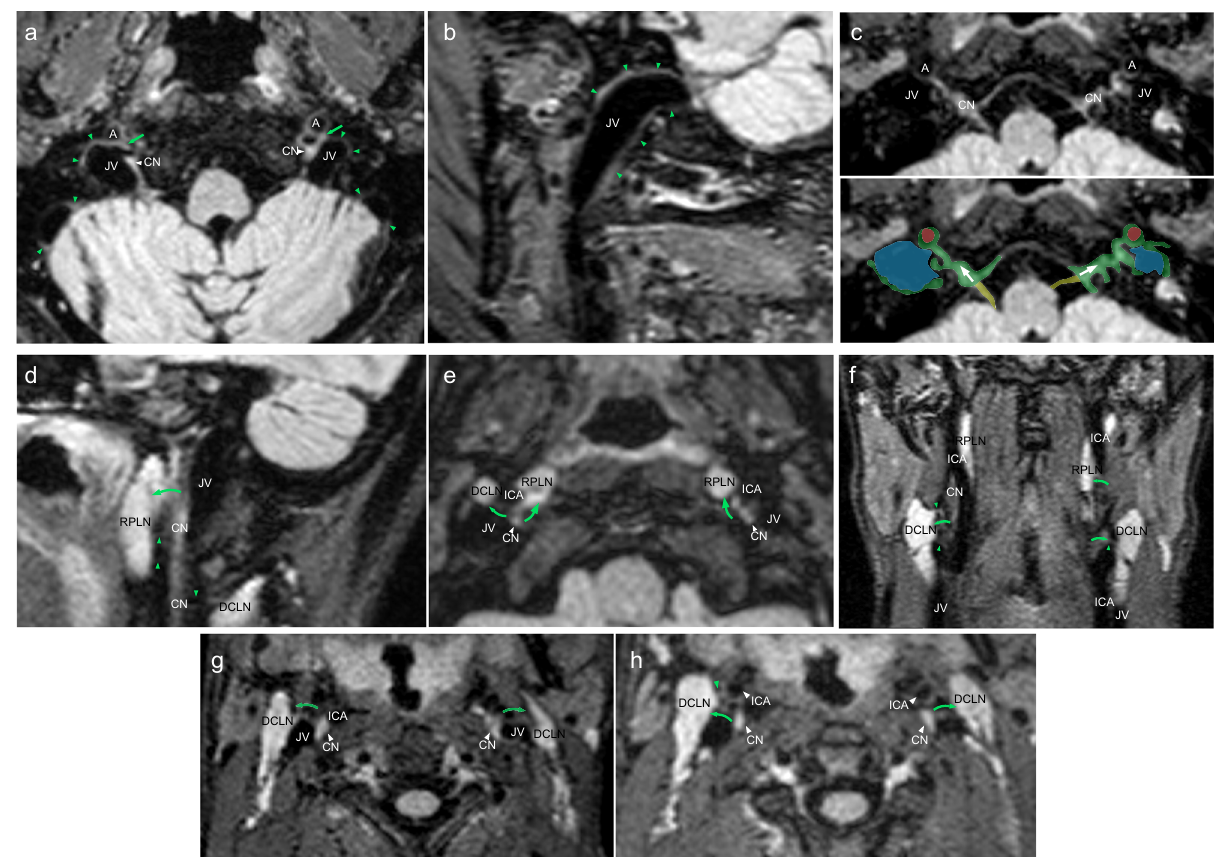
Fig. 5 Depictions of lymphatic drainage at the levels of the skull bases and neck. Axial ( a ) and sagittal ( b ) FLAIR images show prominent lymphatic fl uid signals along the wall of the jugular vein (JV) in the upper neck region (green arrowheads). a Lymphatic signal connections with internal carotid artery (A), JV and cranial nerves (CN) can be seen (green arrows). c Axial magni fi ed image reveals lymphatic signal communications along the cranial nerve IX – XI complex (CN), internal carotid artery (A) and jugular vein (JV). Corresponding color overlay depicts veins (blue), meningeal lymphatic tissue/ fl ow (green; arrows), ICAs (red), and CNs (yellow). Sagittal ( d ), axial ( e , g , h ), and coronal ( f ) FLAIR images depict lymphatic connections from the cranial nerve IX – XI complex to the deep cervical lymph nodes (DCLN; green arrows and green arrowheads) and retropharyngeal lymph nodes (RPLN; green arrows and green arrowheads). Similar types of connections can also be seen between CNs and the ICAs as well as between the ICAs and lymph nodes (green arrows and green